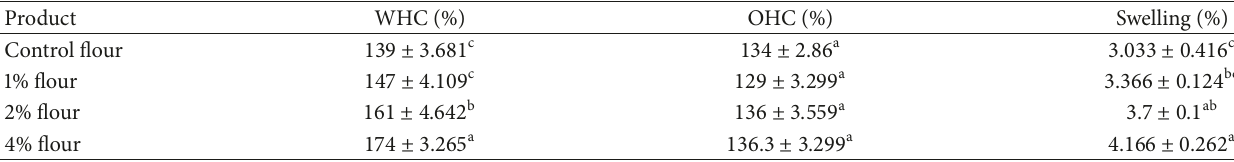
WHC = water holding capacity; OHC = Oil holding capacity; results are presented in the form of mean ± SD of replicates: 𝑛 = 3 ; means with different letter in a column present significant ( 𝑝 ≤ 0.05 ) effect, according to 1-factor ANOVA, and the differences between the means were evaluated by DMR test. The level of significance was 𝛼 = 0.05 .